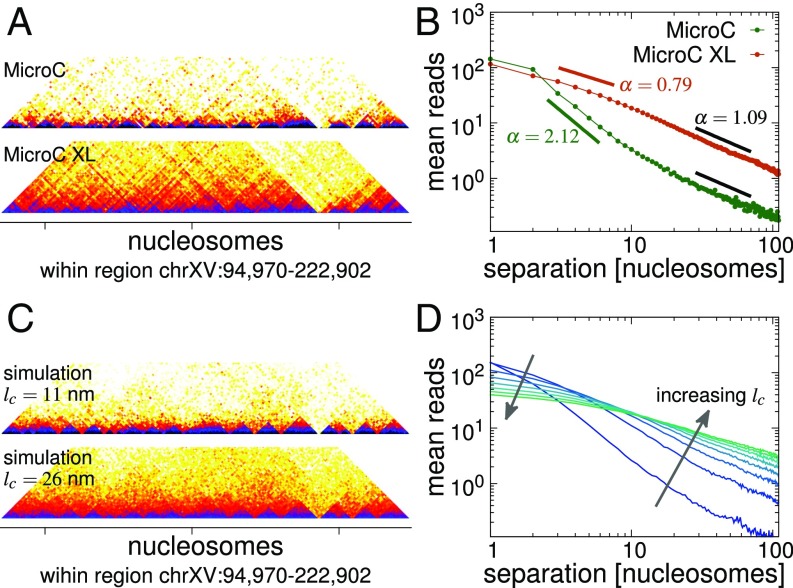
MicroC XL data show similar domains, but how the number of reads decays as a function of genomic separation differs. (A) Plot showing interaction maps (rotated through 45° and cropped) for the same region of chrXV for MicroC (Top) and MicroC XL (Bottom) data from refs. 10 and 11, respectively. The same domains appear in both plots, but the level of interactions differs for larger separations (Bottom map shows darker colors toward the top). (B) Plot showing how, on average, the number of interaction reads between nucleosomes scales with their genomic separation for the 2 experimental datasets (measured in nucleosomes; i.e., a separation of 1 means neighboring nucleosomes). A straight line on a log−log plot indicates a power law, and exponents in different regions are indicated. The points represent an average over all simulated regions. (C) Interaction maps from simulations of the same genome region as in A. The 2 maps are obtained from the same set of simulations, but a different “cross-linking” length scale lc is used to generate the map. Values of lc=11.25 nm and lc=26.25 nm give the best fit to the MicroC and MicroC XL data, respectively (SI Appendix). (D) Mean reads vs. separation plot from simulations (average over all simulated regions). Each line is obtained from interaction maps with different values of lc (lc=7.5,15,22.5,30,37.5,45,52.5, and 60 nm).